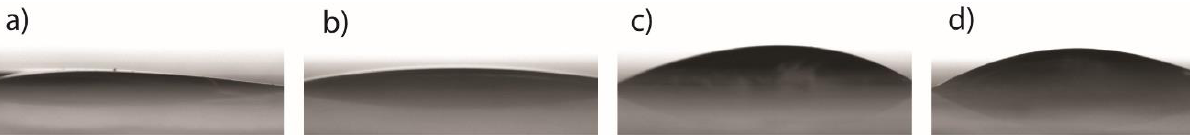
Figure 6. Water contact angle images of ( a ) TiO 2 /SiO 2 99.5/0.5, ( b ) TiO 2 /SiO 2 99.0/1.0, ( c ) TiO 2 /SiO 2 97.0/3.0 and ( d ) TiO 2 /SiO 2 95.0/5.0. 100% TiO 2 sample completely wetted the surface with WCA close to 0.